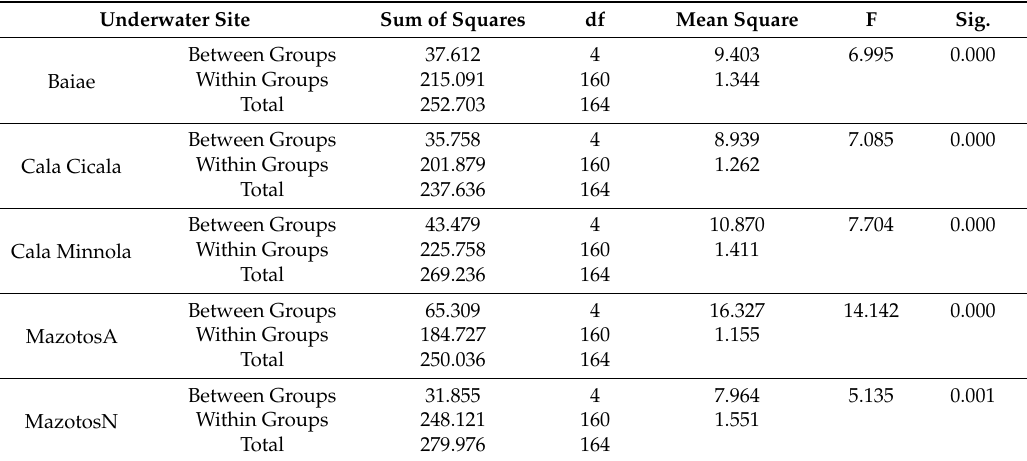
Table 7. ANOVA test